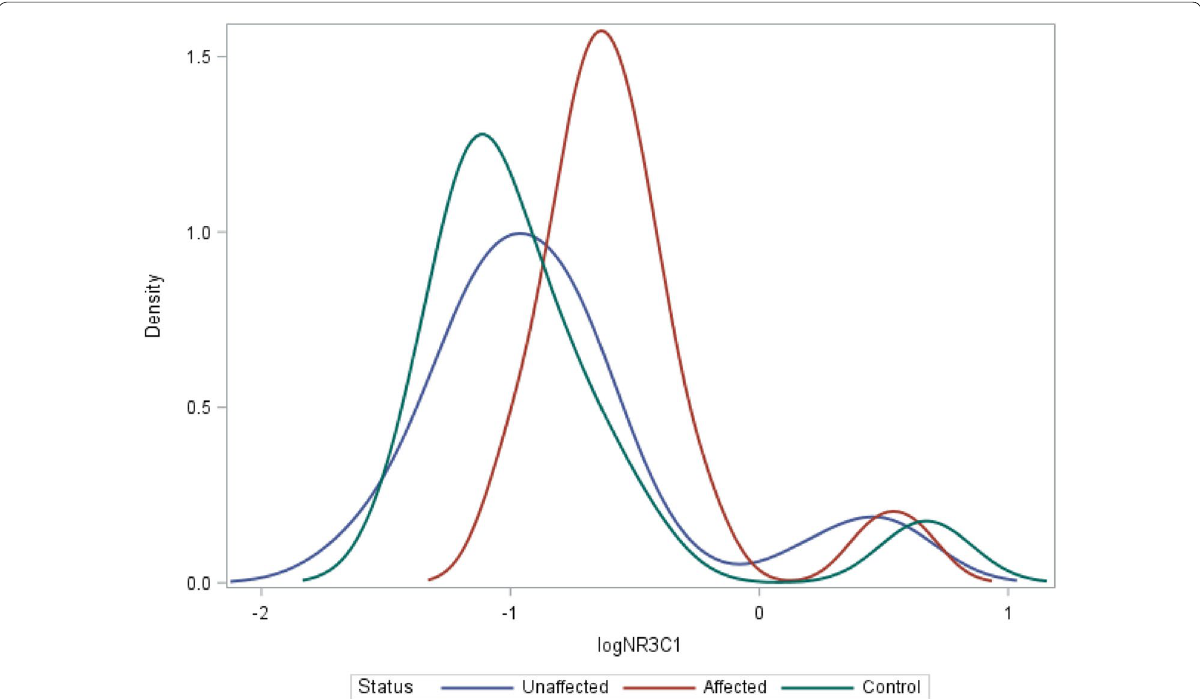
Fig. 2 Kernel smoothed log NR3C1 methylation profiles in cross‑sectional analysis between affected and unaffected high‑risk (HR) offspring and controls. Estimated distribution of log NR3C1 methylation rates. After adjustment, there was evidence that the mean of controls (green) is different from the mean of affected HR (red) (p evidence that the mean of affected (red) was different from unaffected HR (blue) (p